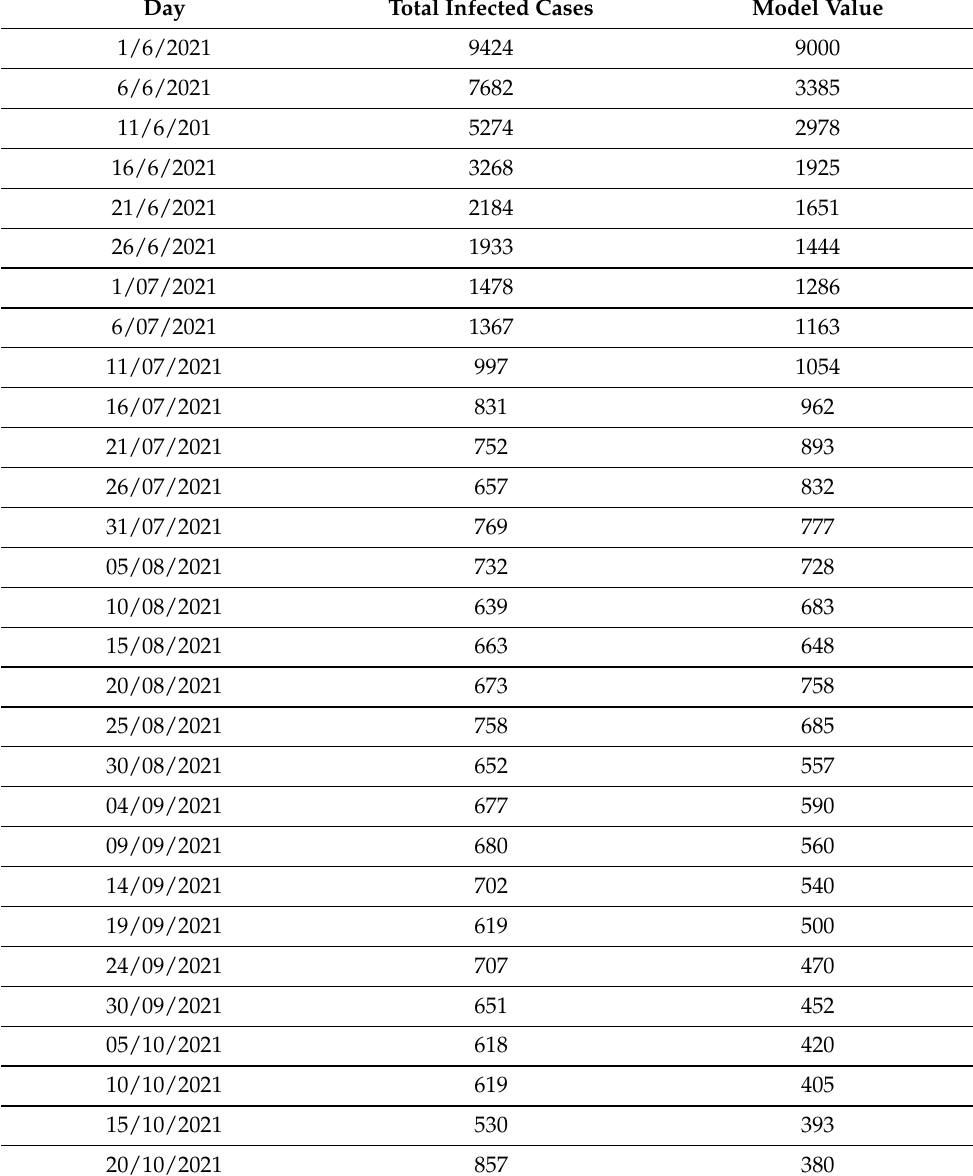
Table 4. Day by day case report between 1 June 2021 and 20 October 2021 of West Bengal